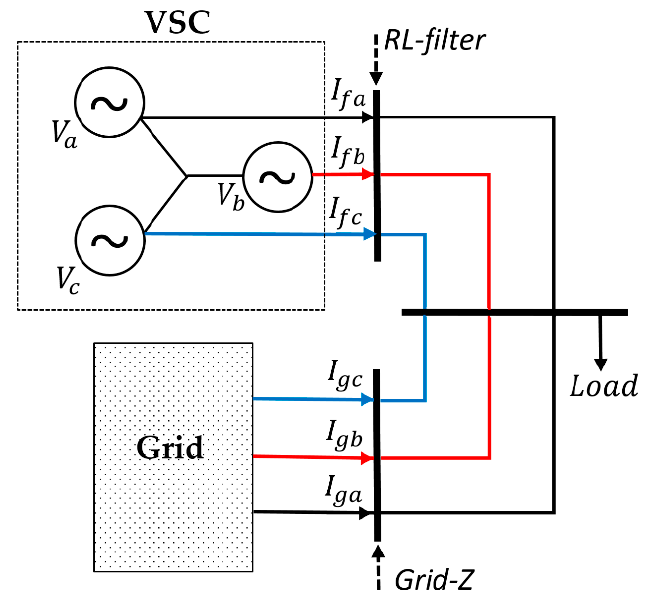
Figure 1. Equivalent model of the considered case study. Table 2. Nomenclatures employed in Equations (1)–(3).